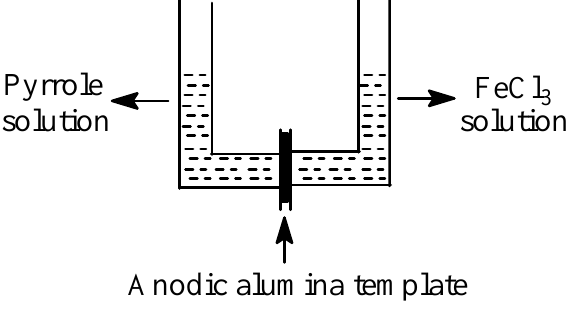
Figure 1. The drawing of reaction